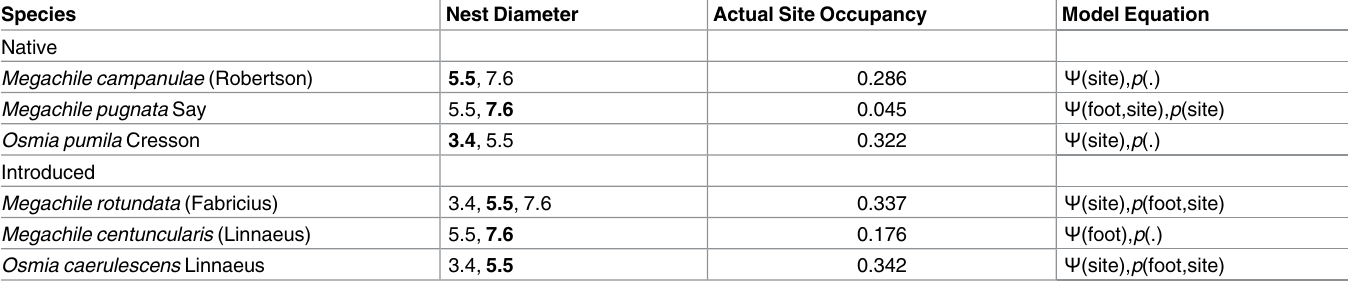
Table 1. A list of the six bee species studied and the model equation used to fit the presence-absence data for each, as collected over the three- year study period. The nesting tube diameters used (the preferreddiameter in bold) and the observedfrequency from the sample across all sites are also included.